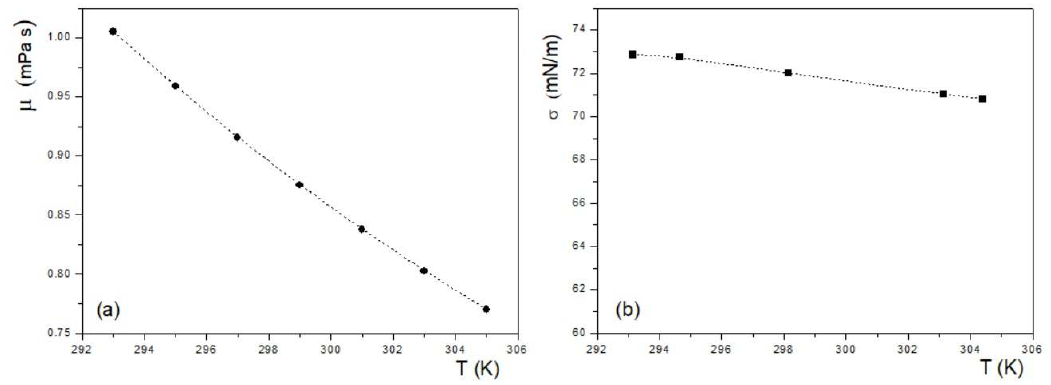
Figure 4. Plots of ( a ) dynamic viscosity of water and ( b ) water-air surface tension as a function of temperature. Data taken from